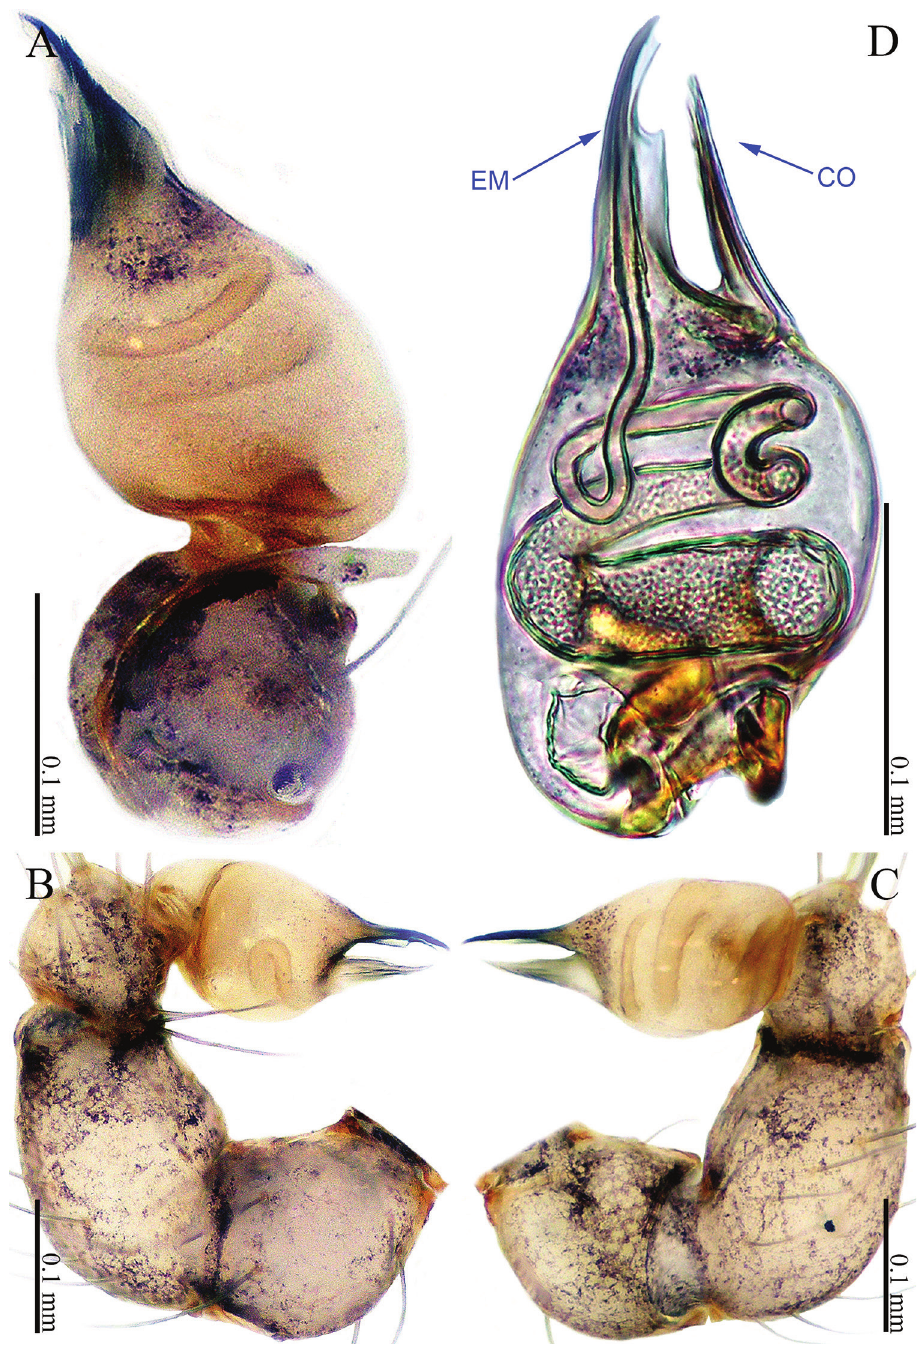
Figure 13. Sinoderces wenshanensis Li & Li, sp. nov., male holotype A palp, ventral view B palp, prolater- al view C palp, retrolateral view D palpal bulb, ventral view Abbreviations: CO conductor, EM